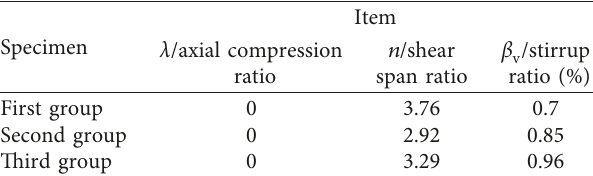
Table 4: Specimens’ axial compression ratios, shear span ratios, and stirrup